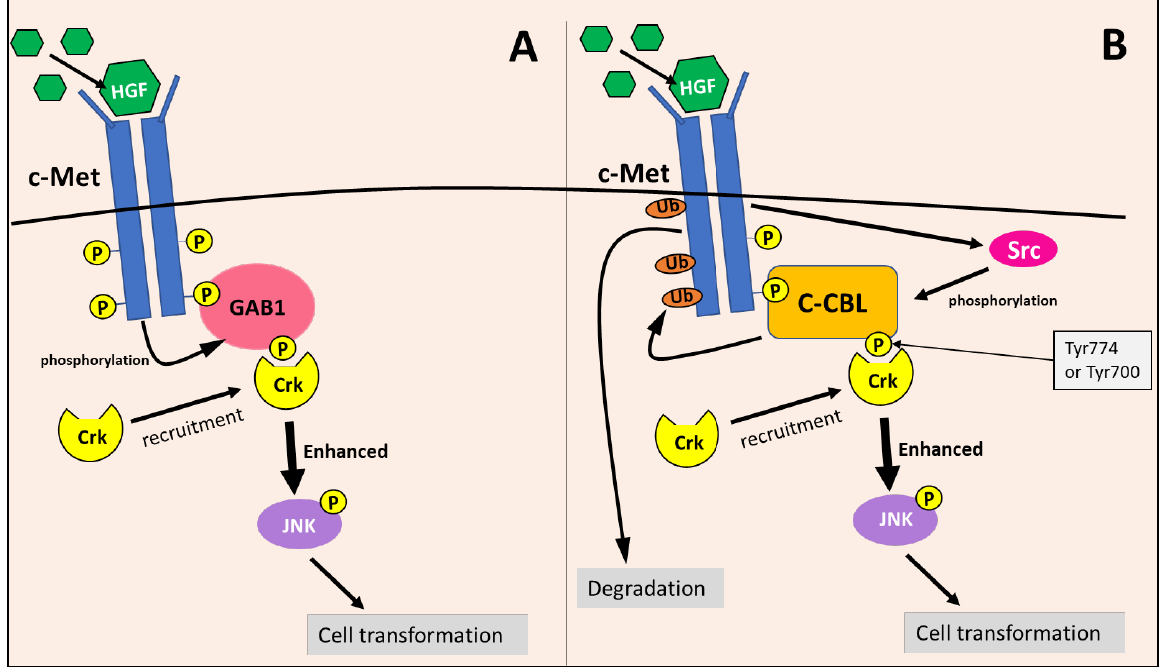
Figure 15. The c-Met/Crk/JNK pathway is enhanced by GAB1 and c-Cbl by promoting JNK phosphorylation. ( A ) c-Met is activated by hepatocyte growth factor (HGF), leading to its autophosphorylation. The adaptor protein, Gab1, recognizes and binds to phosphotyrosine residues on activated c-Met. Then c-Met phosphorylates Gab1 and enables it to recruit Crk (via Tyr residue) to promote JNK phosphorylation. ( B ) Similarly, c-Cbl also recognizes and binds to the phosphotyrosine residues on activated c-Met. Subsequently, c-Cbl is phosphorylated by c-Met-induced Src kinases at either Tyr700 or Tyr774, which enables the recruitment of Crk and the enhancement of JNK phosphorylation. In addition, c-Cbl simultaneously ubiquitinates the c-Met receptor, resulting in its degradation. Both c-Cbl and GAB1 enhance JNK phosphorylation, which promotes cellular transformation.